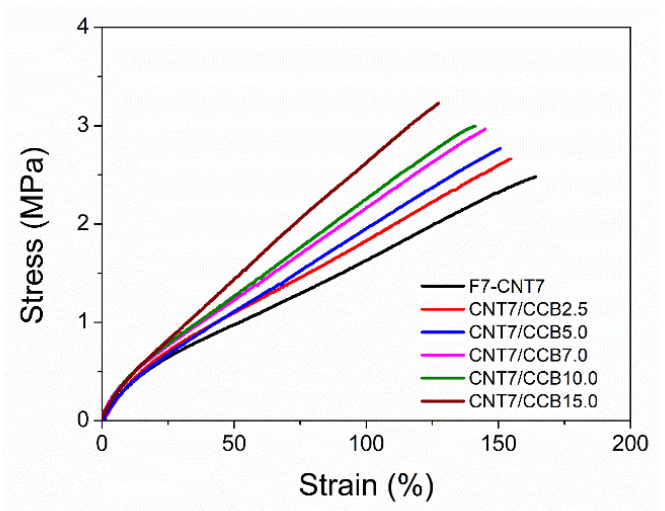
Figure 3. Stress–strain curves of ENR–FeCl 3 filled with 7 phr of CNT (F7-CNT7) and with 7 phr CNT and various CCB loadings at 2.5, 5.0, 7.0, 10.0 and 15.0 (i.e., CNT7/CCB2.5, CNT7/CCB5.0, CNT7/CCB7.0, CNT7/CCB10.0 and CNT7/CCB15.0). Table 3. Tensile properties in terms of 100% modulus, tensile strength and elongation at break of ENR ‐ 50 compounds with FeCl 3 (ENR–FeCl 3 ) filled with CNTs (F7 ‐ CNT7) and CNT–CCB hybrid fillers with various CCB loadings.